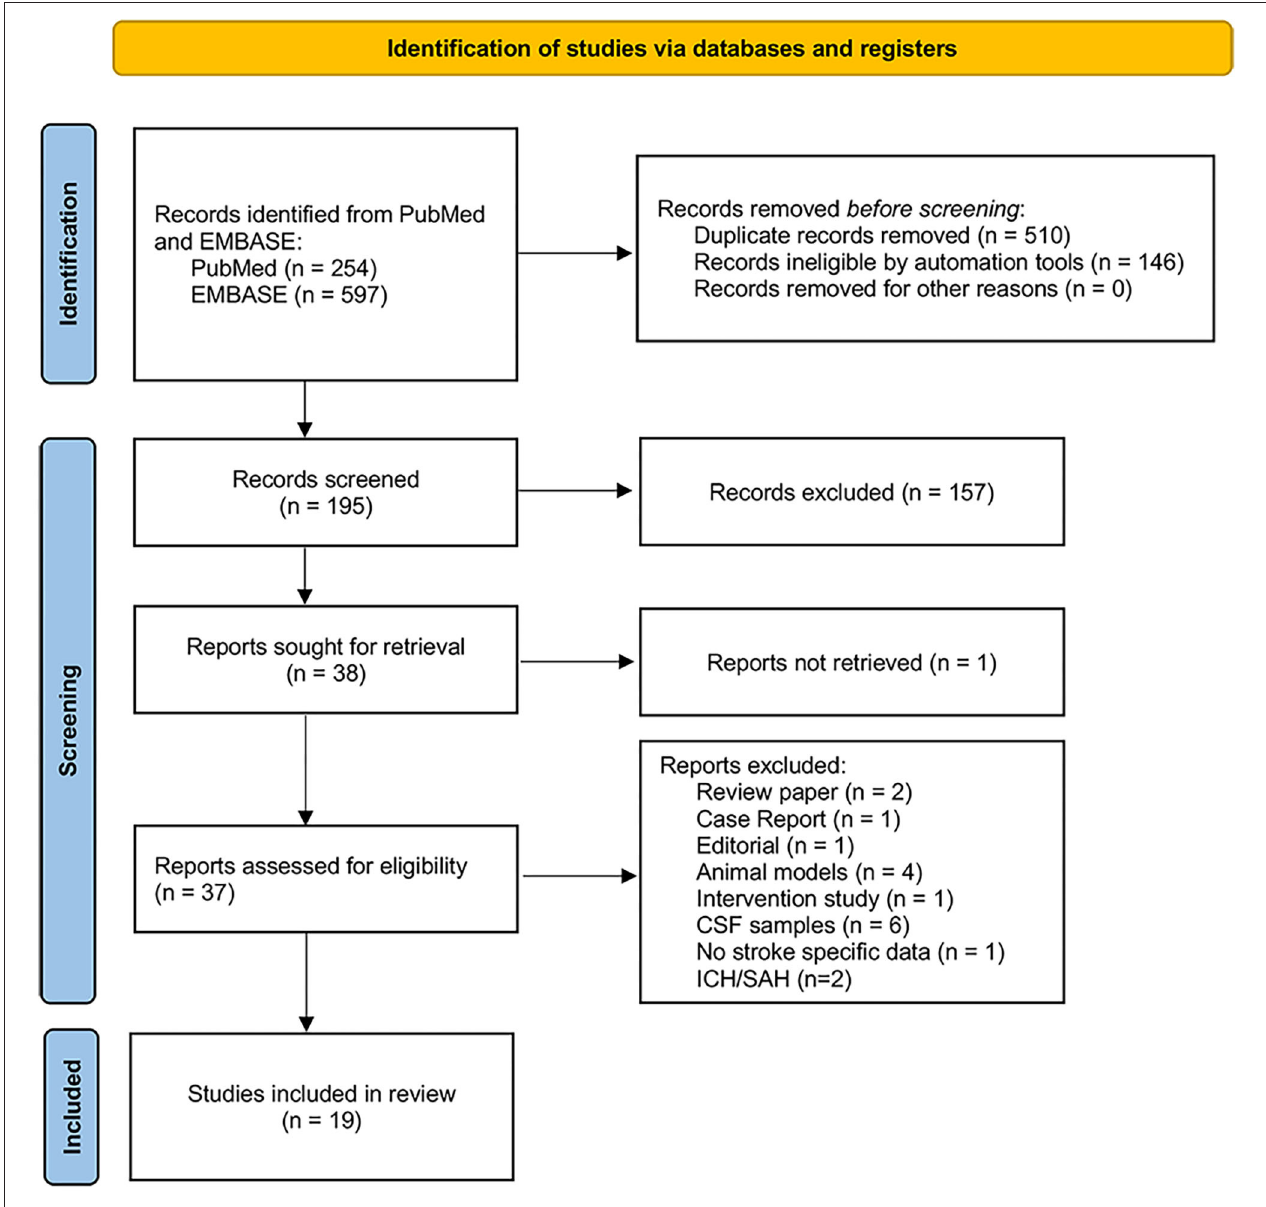
FIGURE 1 | PRISMA flow diagram showing search and study selection